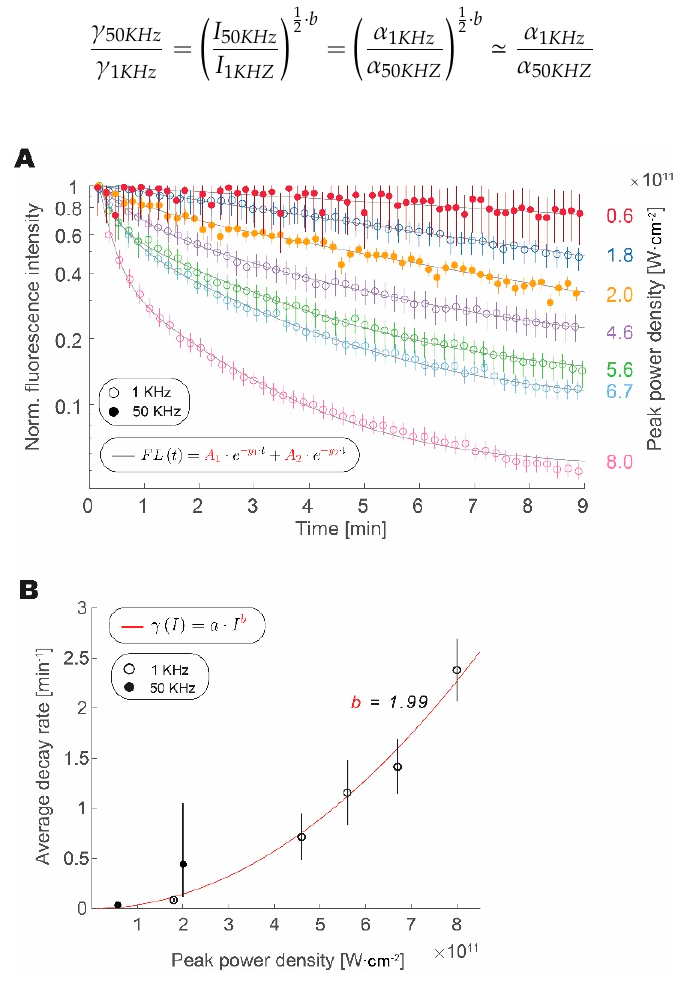
Figure 3. Increased repetition rate does not enhance photobleaching. ( A ) Loss of signal intensity over time with continuous excitation normalized to maximum and shown for 1 kHz (circles) and 50 kHz (full circles) at different peak intensities. ( B ) Amplitude weighted average decay rate scaling with pulse peak intensity for photobleaching at 1 kHz (empty circles) and 50 kHz (full circles) fitted with a power law function (R 2 = 0.96). In all plots, error bars represent bootstrapped confidence intervals of the mean calculated at p = 0.05 confidence level. Data derived from n = 157–214 (1 kHz) and n = 32–56 (50 kHz) measurements of fluorescent microspheres, within 10% area around Gaussian excitation beam